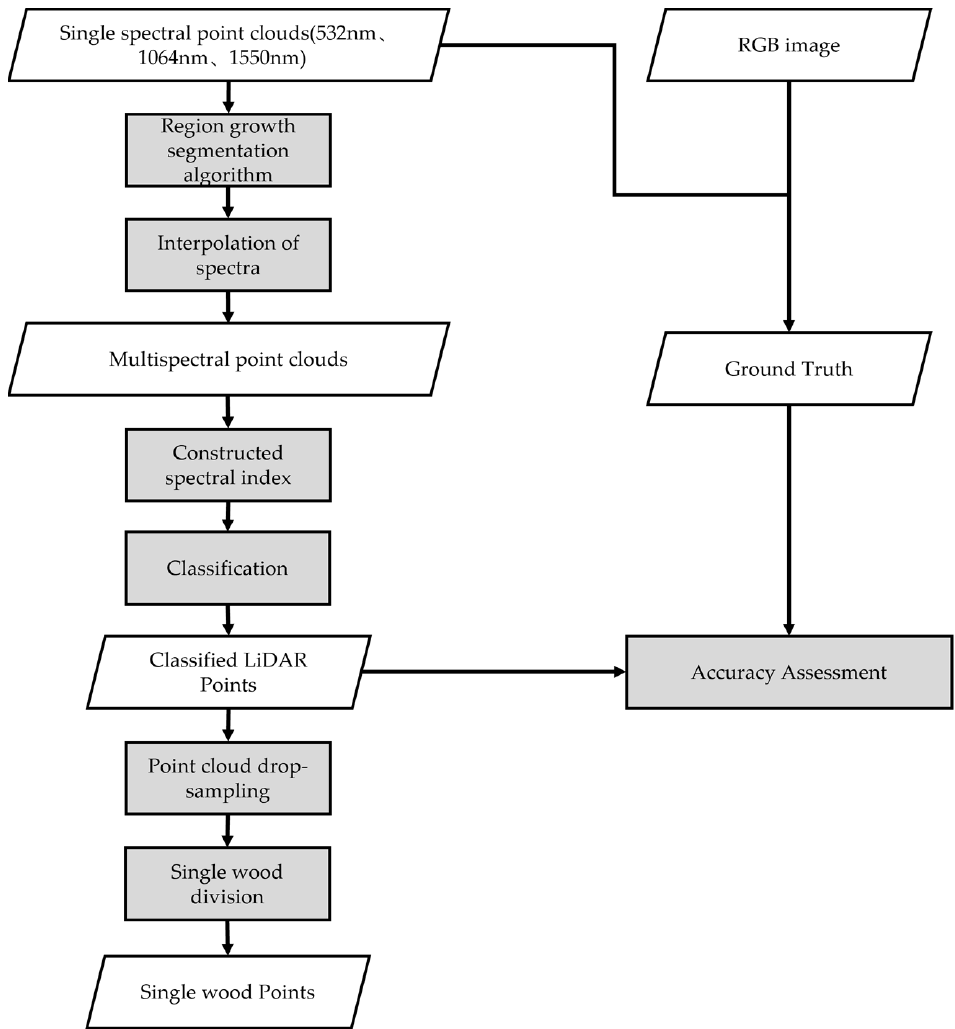
Figure 3. Flowchart detailing the methodology.